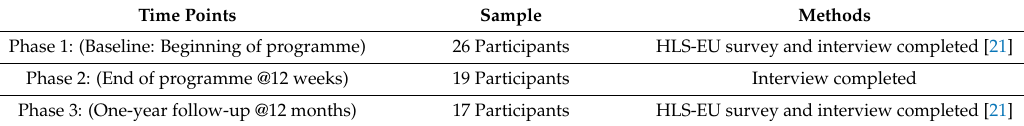
Table 1. Overview of timeline, sample and methods for overall longitudinal qualitative